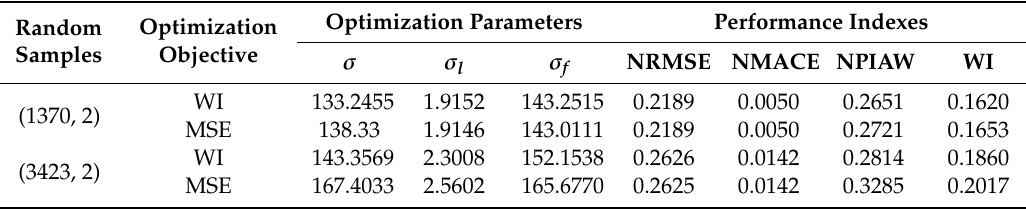
Table 3. Testing of WTPC modeling using different objectives.